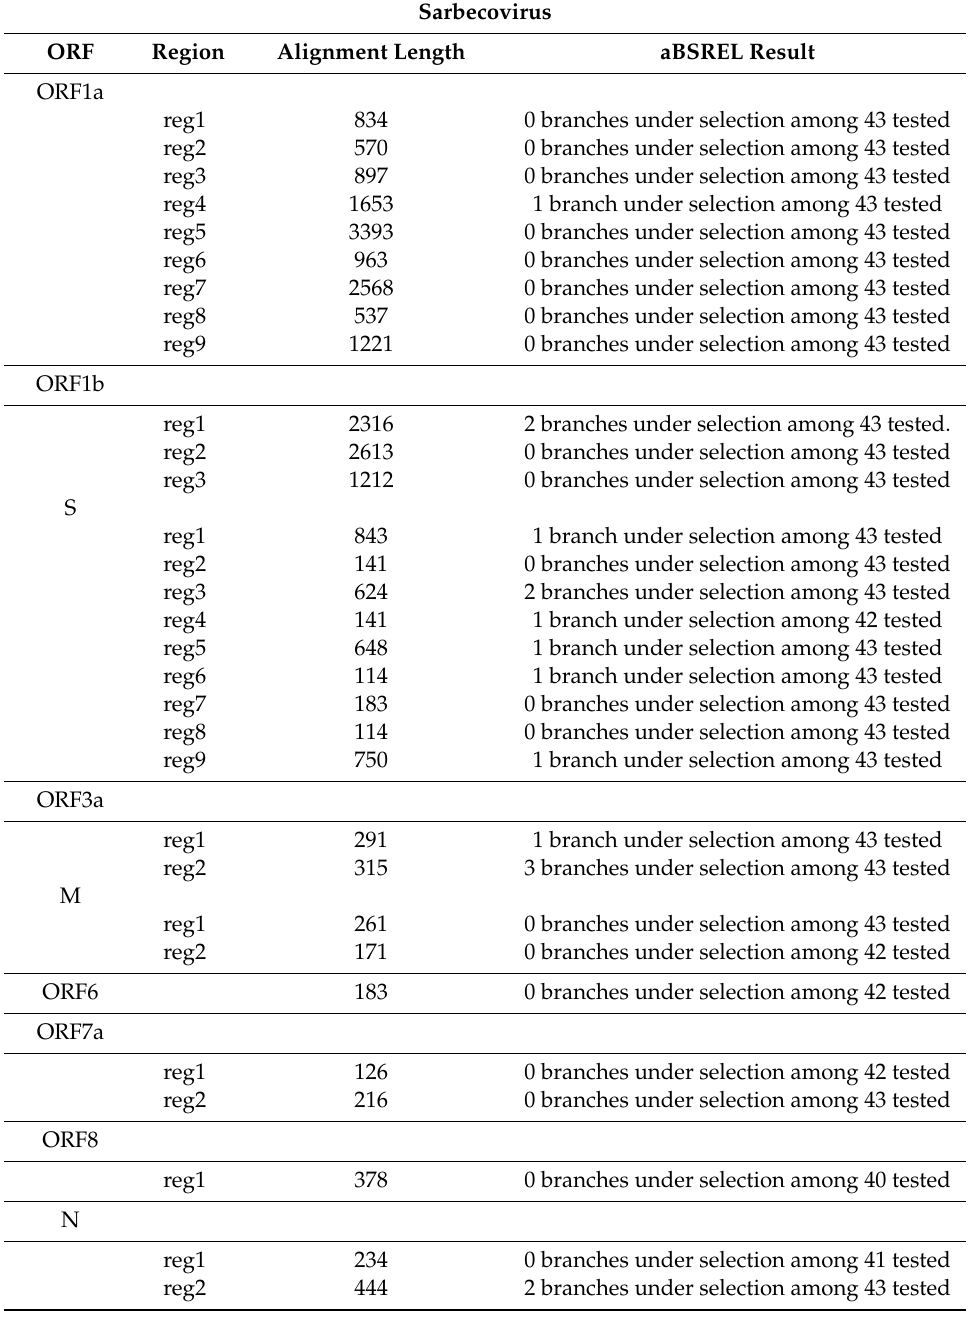
Table 1. Analysis of episodic diversifying selection in sarbecovirus open reading frames